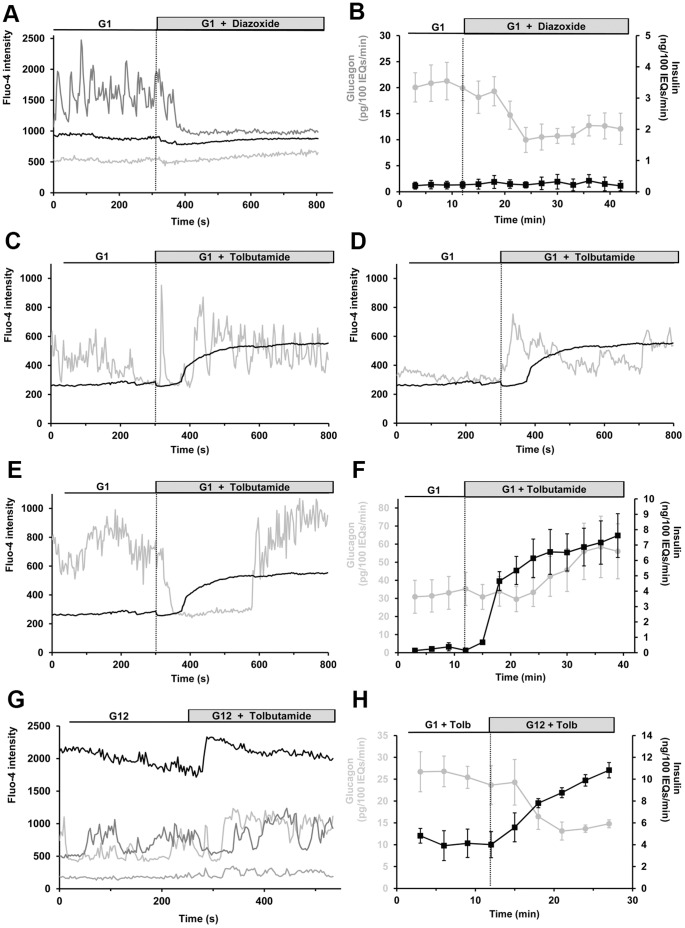
Effects of pharmacological modulation of KATP channels on islet [Ca2+]i and hormone secretion.Gray and black traces represent α- and β-cells, respectively. A, representative intracellular calcium responses to KATP channel activation by 100 µM diazoxide from an islet perifused at 1 mM (G1). Fluo-4 intensity is expressed in arbitrary units. The figure is representative of 25 α-cells analyzed from 7 islets harvested from 3 mice. B, Effect of diazoxide on hormone secretion from intact perifused islets. Isolated islets were exposed to 1 mM glucose for 30 minutes (from -30 to 0 min). Glucagon and insulin responses were measured for 12 minutes at 1 mM glucose, and diazoxide was perifused for 30 minutes at 100 µM. Experiment was repeated 3 times, 450 islets from 6 mice were used. Error bars represent the standard error of the mean. C, D, and E, representative Fluo-4 responses to KATP channel inhibition from an islet perifused at 1 mM glucose. The figure shows 3 different α-cells from the same islet exposed to 100 µM tolbutamide, and is representative of 34 α-cells analyzed from 10 islets harvested from 3 mice. F, glucagon and insulin responses were measured for 9 minutes at 1 mM glucose, and then tolbutamide was perifused at 100 µM. Experiment was repeated 6 times, 900 islets from 12 mice were used. G, representative Fluo-4 responses to 100 µM tolbutamide (TTX) in an intact islet perifused at 12 mM. H, glucagon and insulin secretion from islets perifused at 1 mM glucose and 100 µM tolbutamide for 15 minutes, then glucose concentration was increased to 12 mM. Experiment was repeated 3 times, 450 islets from 6 mice were used.